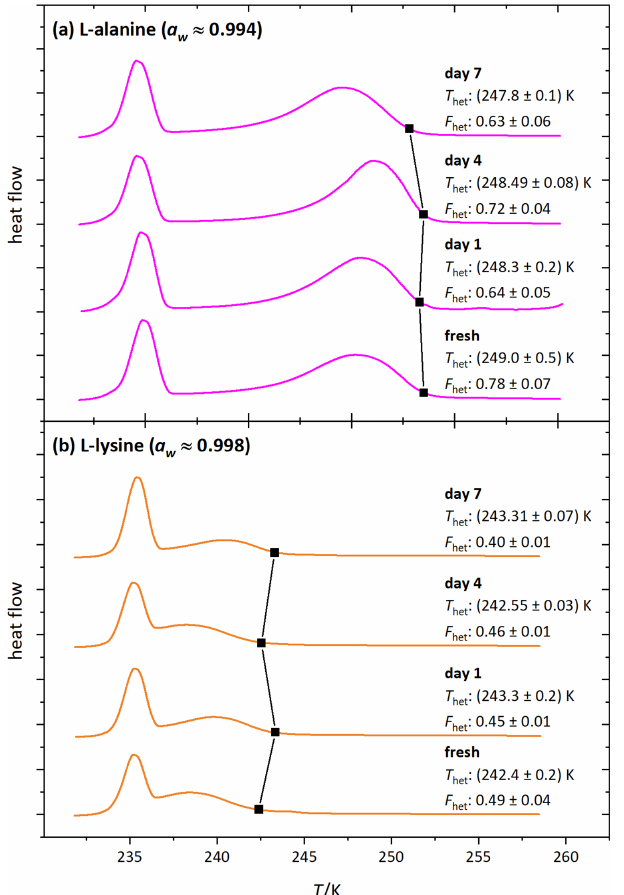
Figure 9. DSC thermograms of microcline (2wt%) in (a) aqueous l -alanine solutions (1wt%; a w ≈ 0 . 994) and (b) aqueous l -lysine solutions (0.1wt%; a w ≈ 0 . 998) measured directly after prepara- tion (fresh) and on the displayed days (days 1, 4, 7). Black squares mark the heterogeneous freezing onset temperatures. The thermo- grams are normalized with respect to their total integral. The dis- played T het and F het values are the average of two measurements. The corresponding uncertainties are the standard deviation.